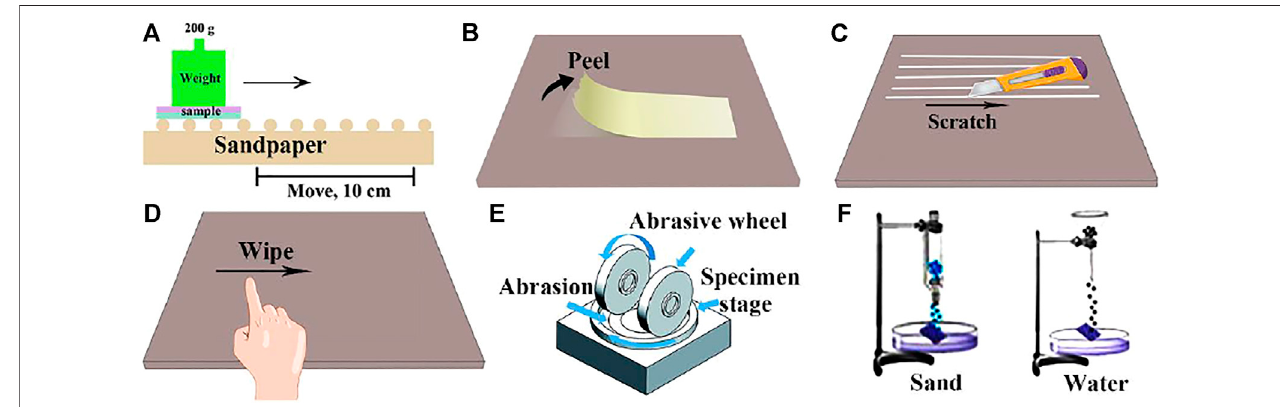
FIGURE3| Wearresistancetest: (A) Sandpaperabrasion. (B) Tape-peeltest. (C) Knife-scratchtest. (D) Fingerwipingtest. (E) Taberabrasiontest(Yeetal.,2017). (F) Sand or water impact